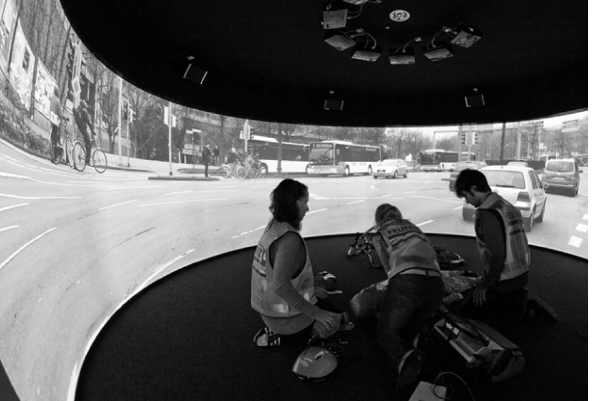
Figure 2. Students are able to interact with simulaton patents within the SimuScape